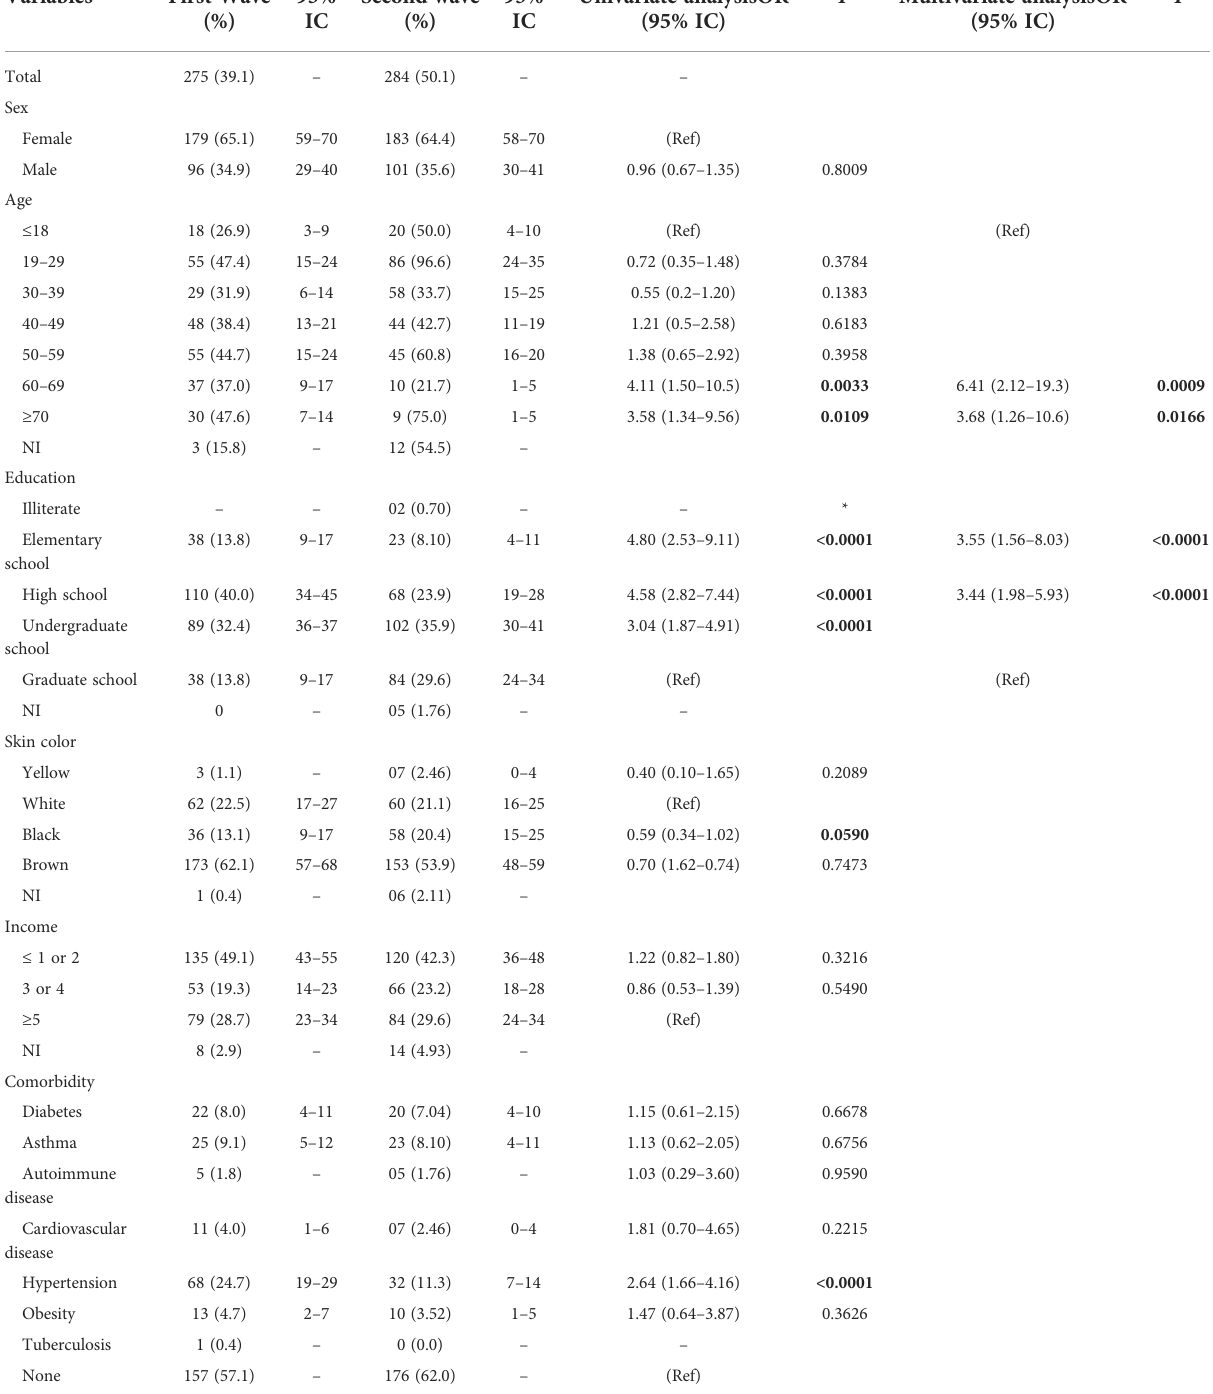
TABLE 1 Socioeconomic characteristics, prevalence of comorbidities, and risk of SARS-CoV-2